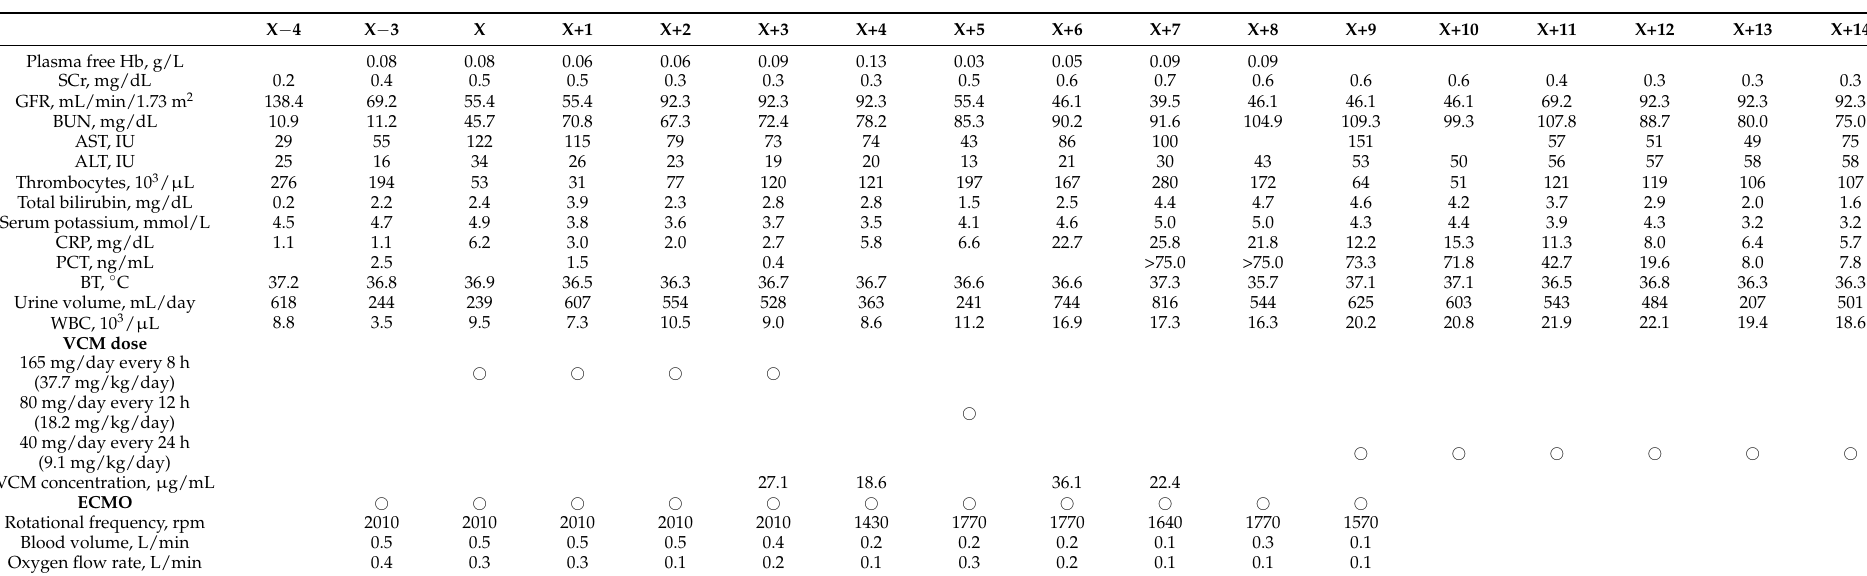
Table 1. Laboratory variables during pre-ECMO (day X − 4 to day X − 1), ECMO (day X to day X+10), and post-ECMO (day X+11 to day